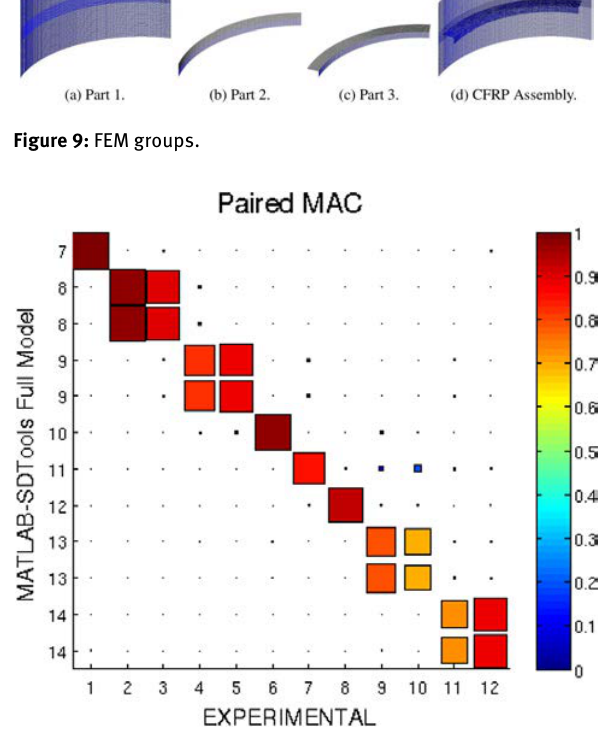
Figure 10: MAC: SDTools vs. Exp. [10]